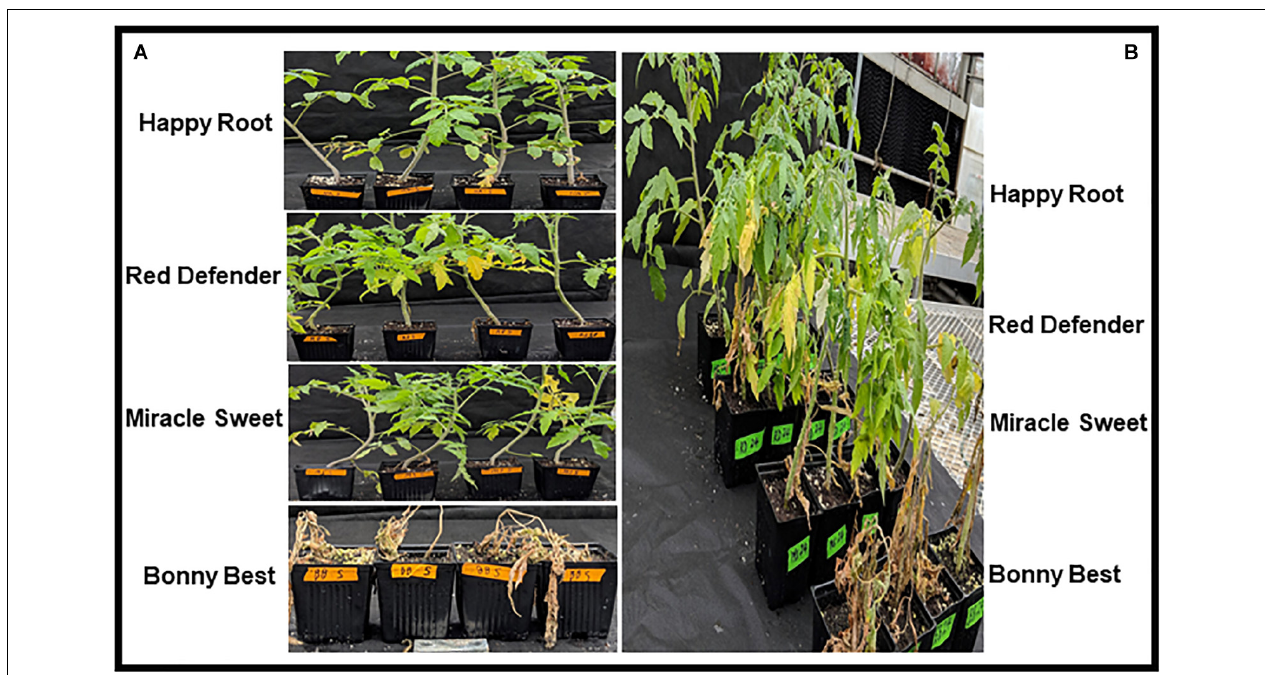
FIGURE 2 | Disease phenotypes caused by Fusarium oxysporum f. sp. lycopersici on four tomato cultivars 21 days after inoculation in the greenhouse. Tomato differential cultivars inoculated with race 1 isolate Fu 5 (A) , and tomato differential cultivars inoculated with race 3 isolate Fu 24 (B)